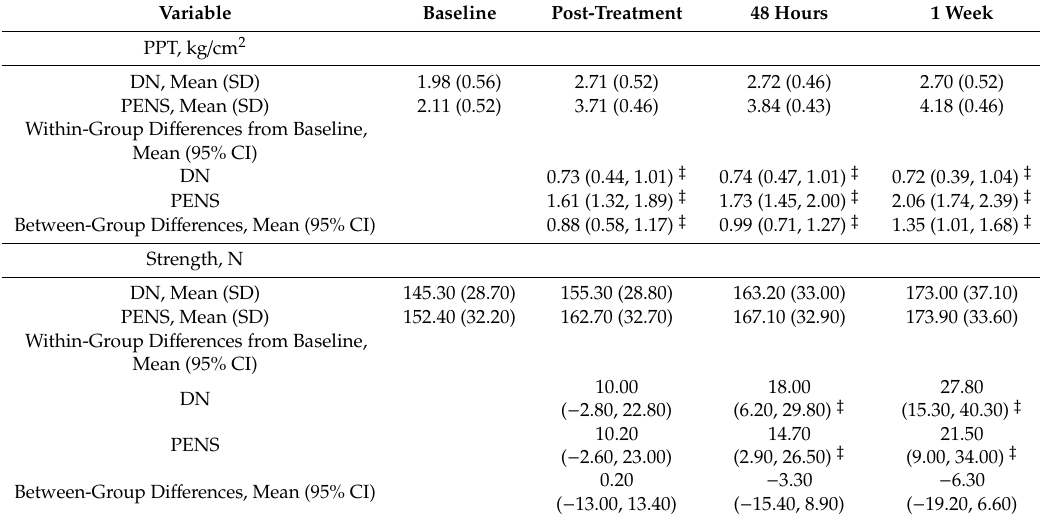
Table 3. Pressure pain threshold and strength di ff erences within- and